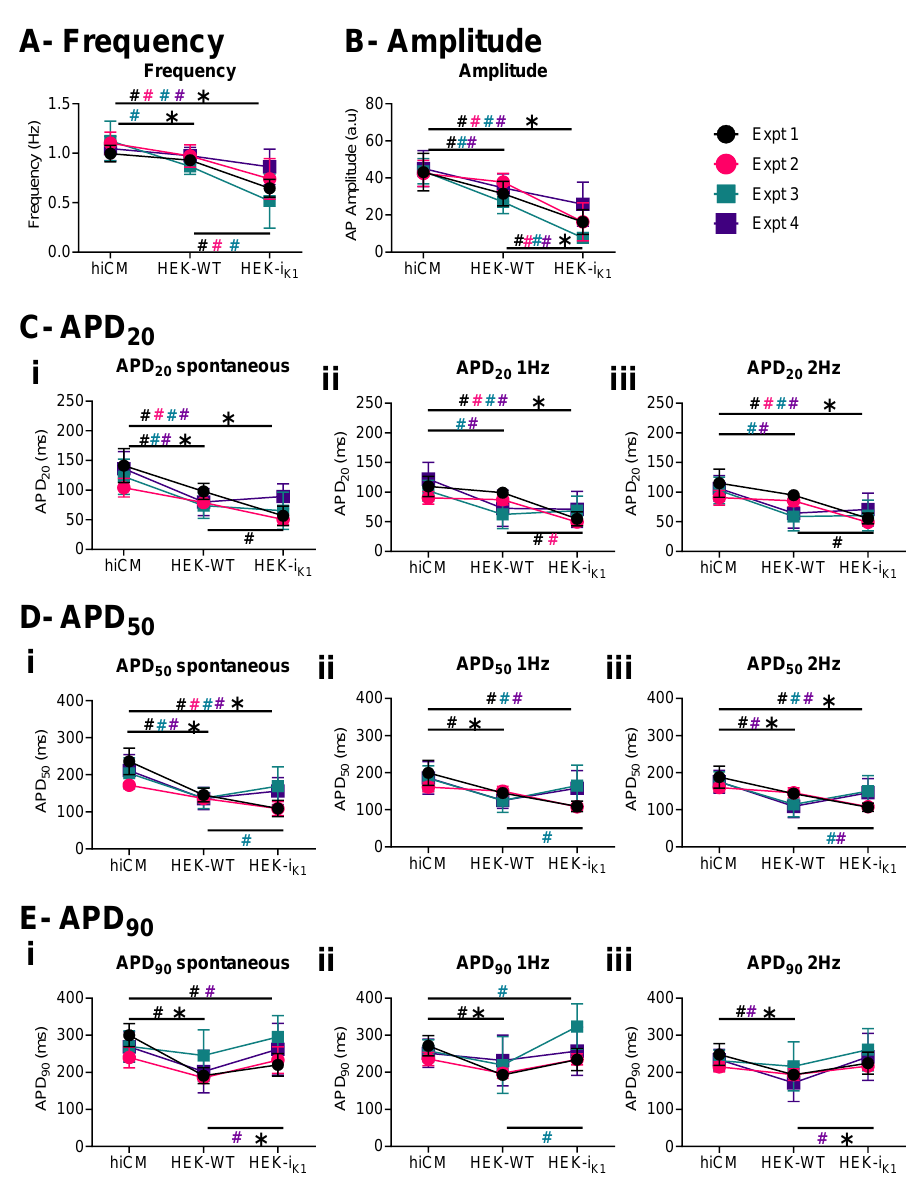
Figure 4. Electrophysiological effects of 1:1 co-culture on day 4 in vitro in serum-free conditions, showing the observations from individual experiments. Each plating is shown in a different color, and data are presented as mean+/−SD. ( A ) Frequency of spontaneous beating. ( B ) Amplitude of the AP. ( C ) APD20 at ( C )( i ) spontaneous, ( C )( ii ) 1Hz, and ( C )( iii ) 2Hz. ( D ) APD50 at ( D )( i ) spontaneous, ( D )( ii ) 1 Hz, and ( D )( iii ) 2 Hz. ( E ) APD90 at ( E )( i ) spontaneous, ( E )( ii ) 1 Hz, and ( E )( iii ) 2 Hz. Due to the small AP amplitude and low signal-to-noise ratio (SNR) (Supplementary Figure S3) in HEK-I K1 :hiCM, fewer data are available for APD90 at spontaneous rates. Comparison of each culture (hiCM, HEK–WT:hiCM and HEK-I K1 :hiCM) within each experiment is shown as # in the respective experimental color, and 2-way ANOVA was used for statistical analysis. The mean of all experiments was then compared using a paired t-test and this is shown with * ( p < 0.05). The early repolarization phase (APD20) was decreased by 25% compared to control values (100% hiCM culture) at the spontaneous rate (HEK-I K1 :hiCM: 74.2 ± 4.2 ms and